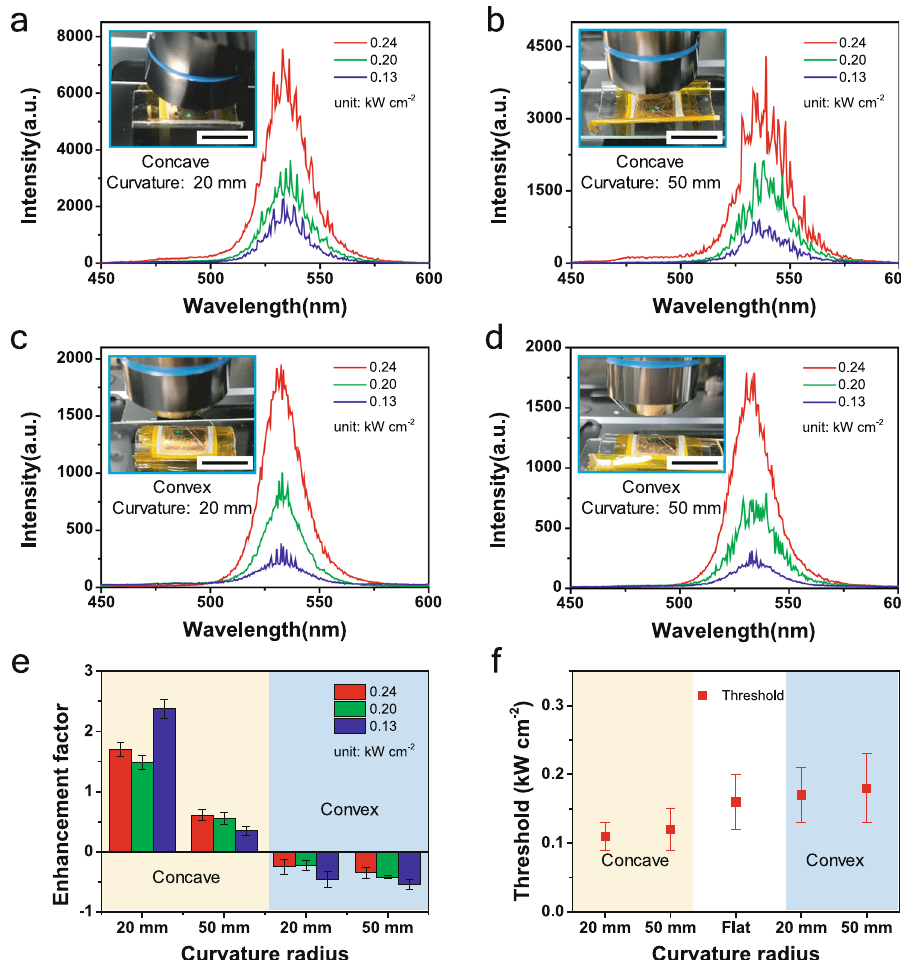
Fig. 5 Curvature realization of the fl exible and rollable HMM device. The emission spectra of random lasing action for the HMM2 device on the concave glass substrates under the curvature radius of a 20 mm and b 50 mm with the corresponding insets. c , d The emission spectra on the convex glass substrates under the curvature radius of 20 and 50 mm, respectively. The insets are the corresponding photo images. e The enhancement factors of concave and convex substrates as compared with the planar substrate. f The threshold variations with the curvature radius for the fl exible and rollable HMM structure on concave and convex substrates. Error bars are the standard deviation of spectra fl uctuation of random laser action from 15 datasets. All the measurements were performed under the same pumping energy density of 0.24, 0.20, and 0.13 kW cm − 2 . All the scale bars are 1